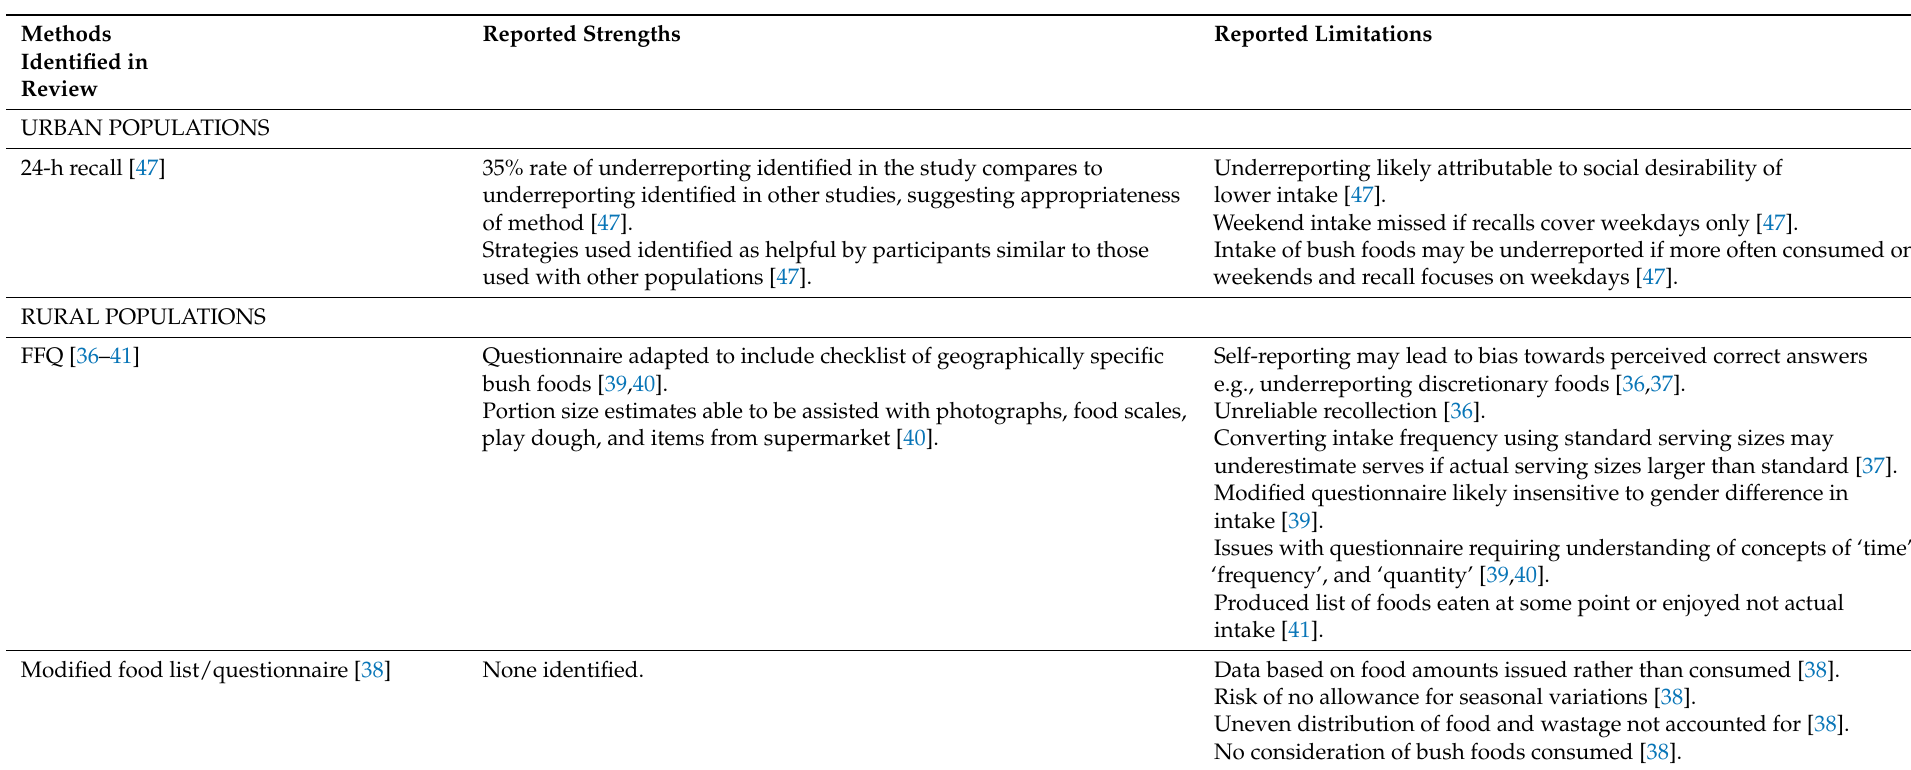
Table 2. Reported strengths and limitations of identified dietary assessment methods to understand the applicability for Aboriginal and Torres Strait Islander people and communities by